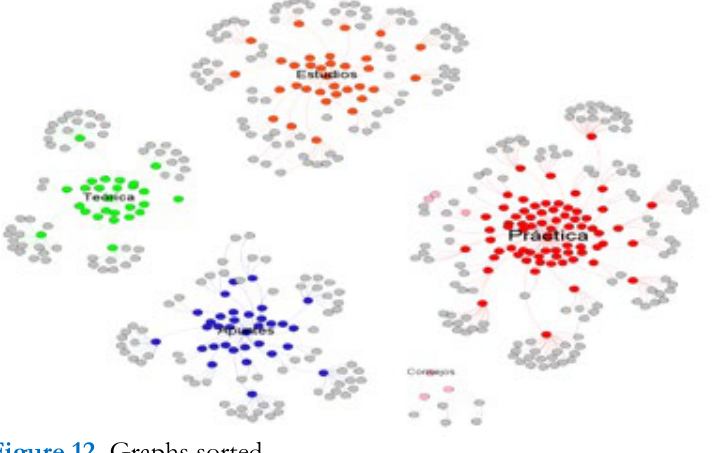
Figure 12. Graphs